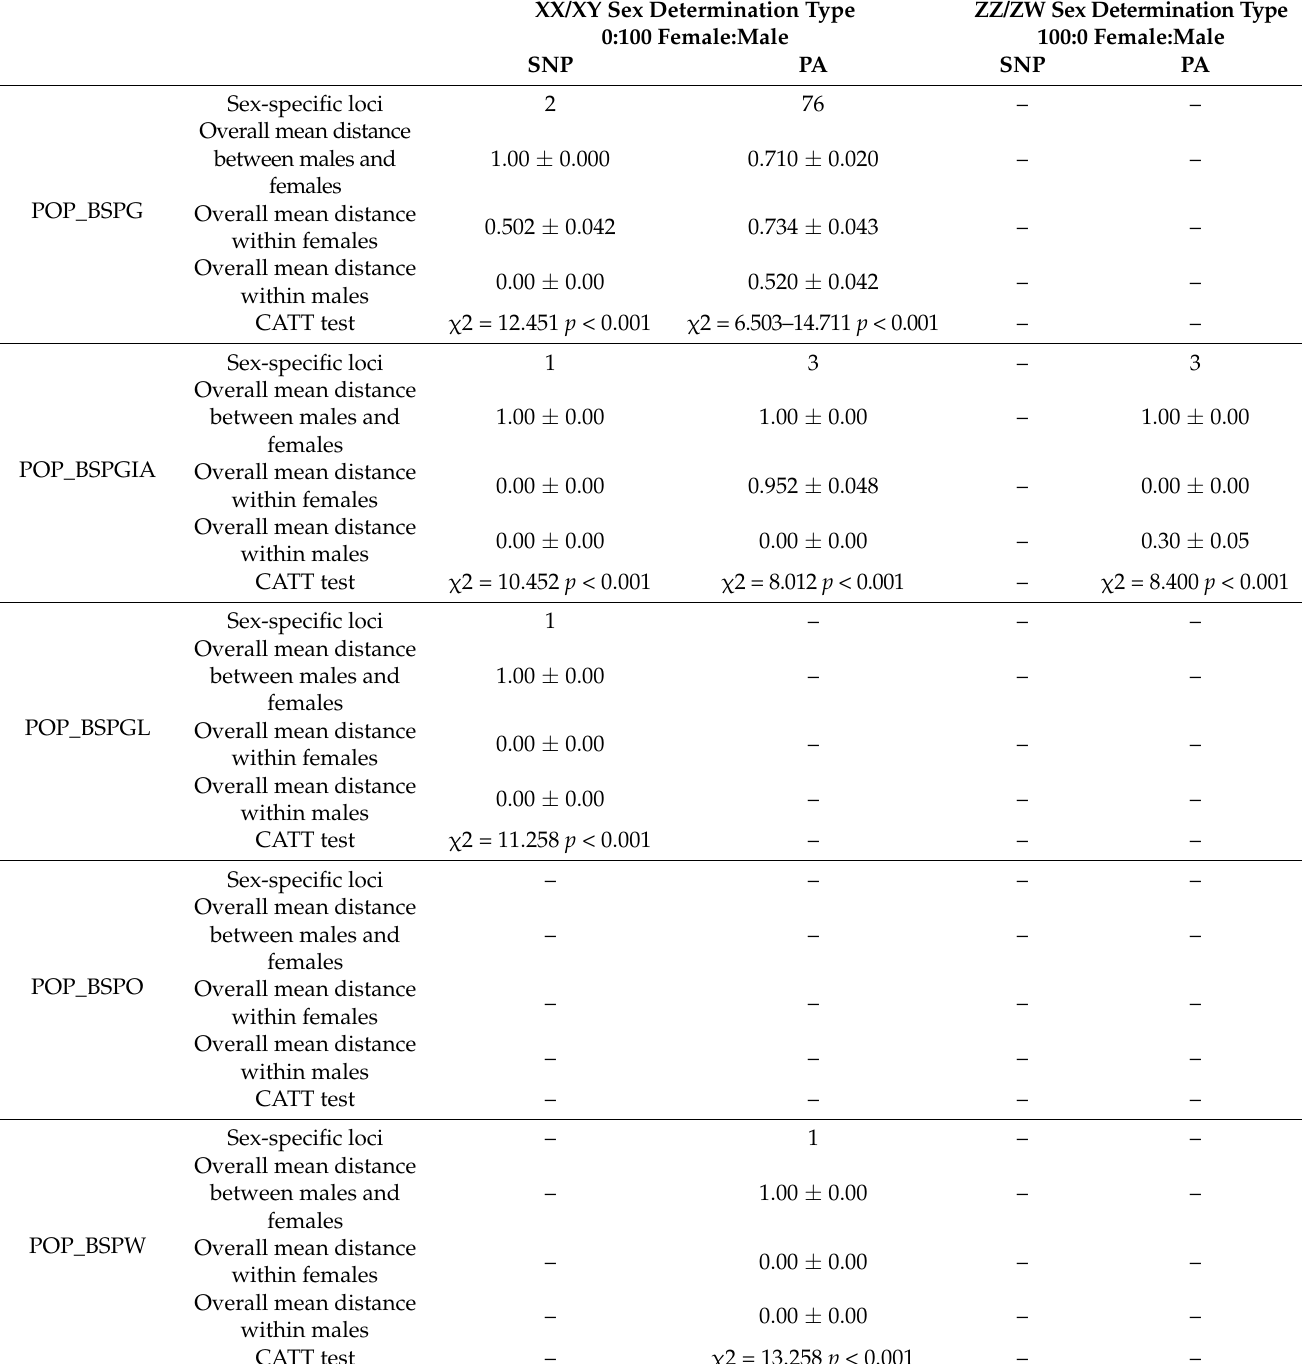
Table 1. DarT analysis of 75 Siamese fighting fish (40 males and 35 females) (XX/XY and ZZ/ZW sex determination